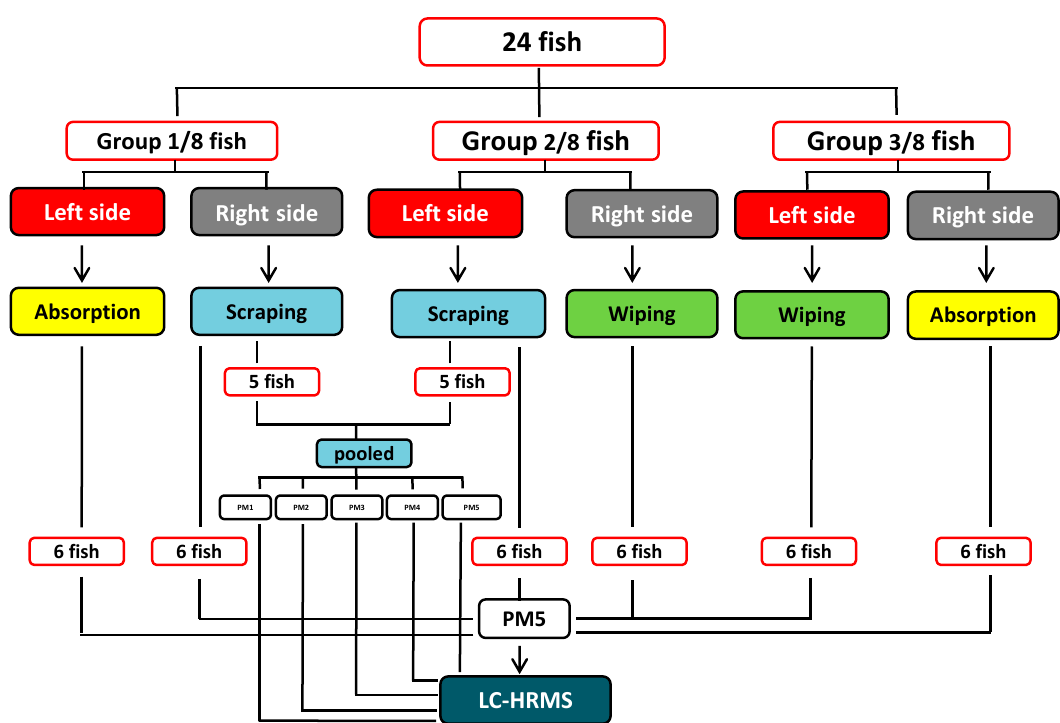
Figure 6. Schematic flow diagram of epidermal mucus sampling.